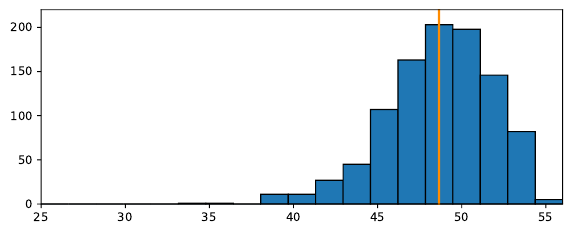
Figure 24: Histogram of security levels after template attacks on 1k keys using 900 traces per key. The average security level, marked by an orange line, is at 48.7